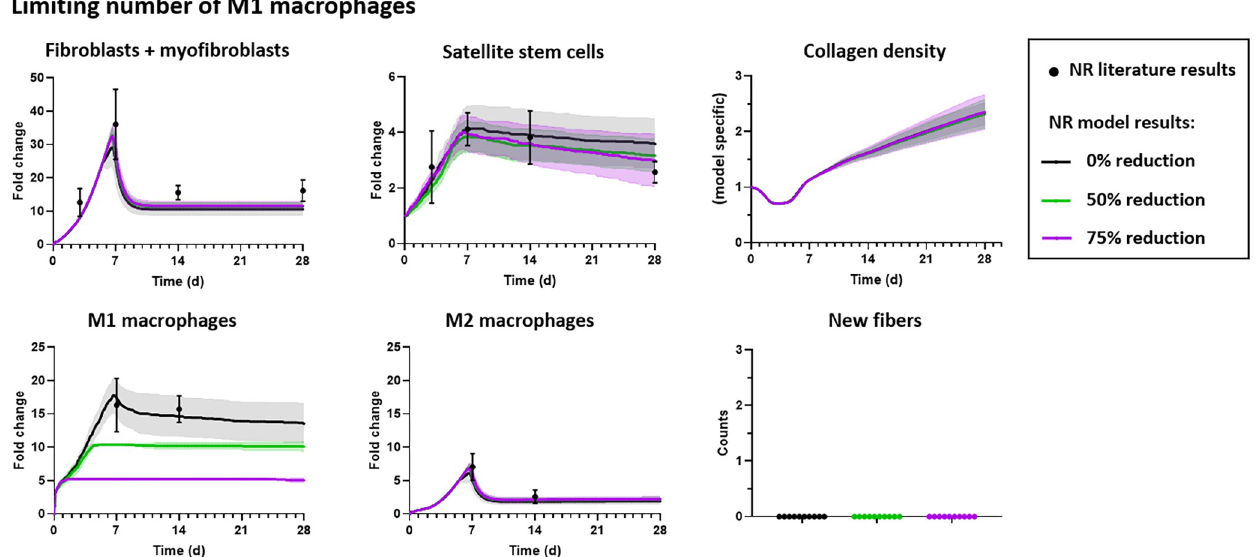
Fig 6. Limiting the number of M1 macrophages in the no repair (NR) ABM did not alter the amount of fibrosis as indicated by collagen density nor result in new muscle fibers filling the defect. The number of M1 macrophages was reduced to 50% and 75% of baseline levels. Outputs included fibroblast and myofibroblast fold changes, SSC fold changes, collagen density, macrophages fold changes, and number of new, regenerated fibers. Model results were reported as mean ± 95% confidence interval. Aguilar et al. 2018 experimental data of fibroblasts and SSCs reported as median ± standard deviation, and Garg et al. 2014 experimental data of M1 and M2 macrophages reported as mean ± standard error mean [9,23].